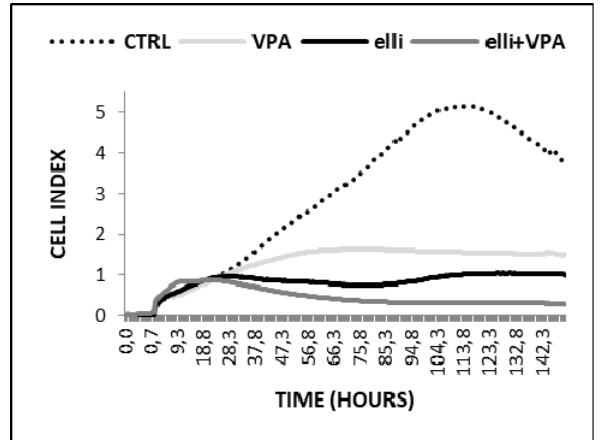
Figure 2. Cell index of UKF-NB-4 cells affected by 5 µM ellipticine (elli), 1 mM valproic acid (VPA) and their combination. Representative data from one of three independent experiments are shown.